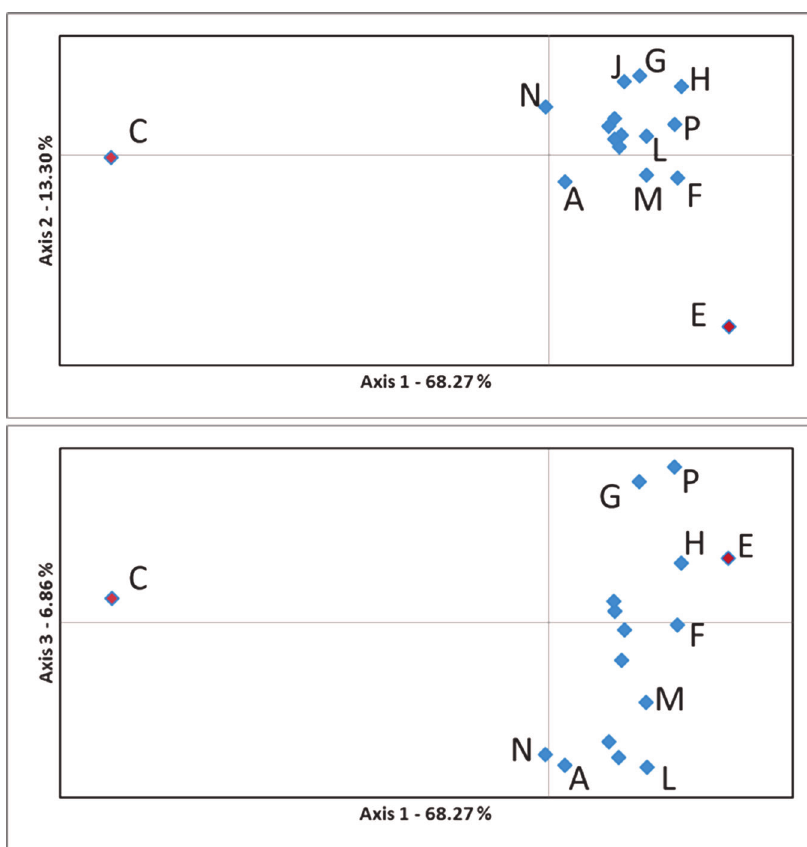
Figure 2. Representation of principal component analysis (PCA) of estimated pairwise FST values obtained by Genalex software. Blue labelled herds are in the range of low genetic differentiation. Red labelled herd C have moderate genetic distance from the other populations, while herd E moderately differentiated from G, H, J, L, N, and P populations. Percentage values represent variation justified by each